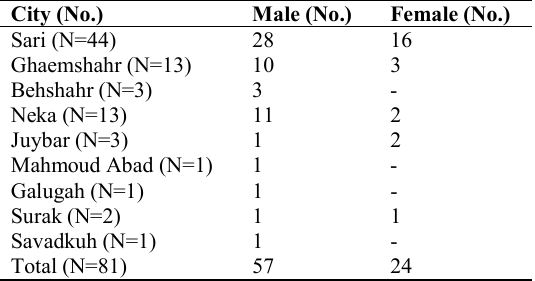
Table 3. The demographic information of gastric cancer